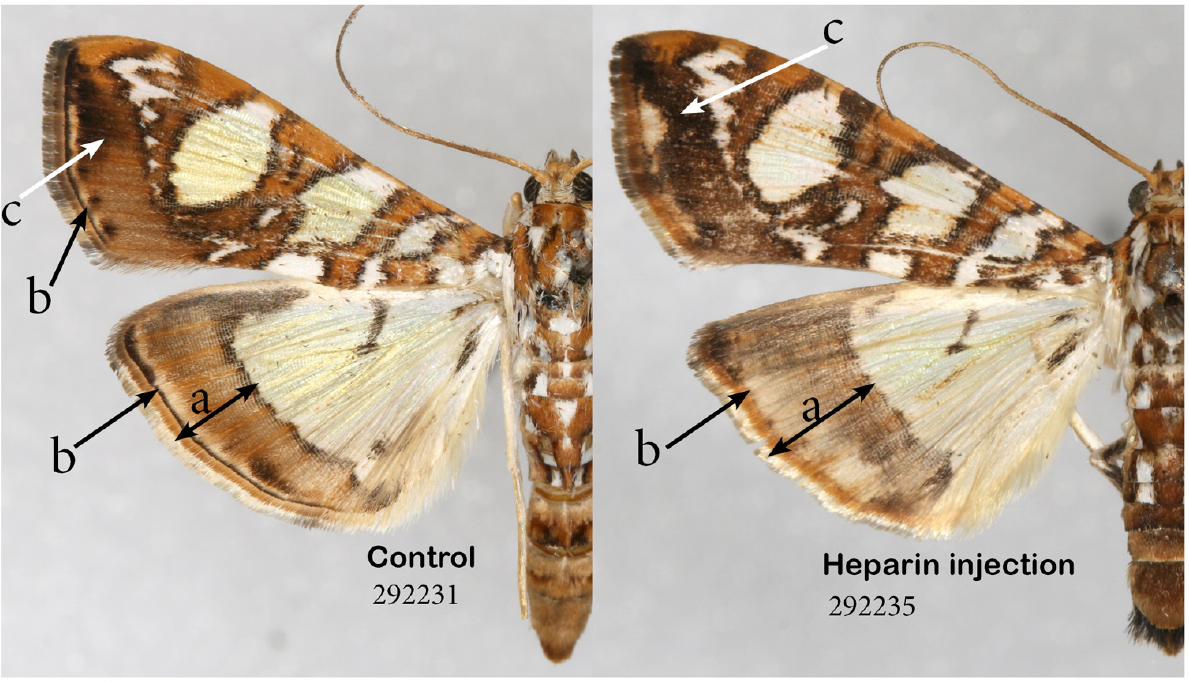
Figure 10. Normal individual of the mulberry leaftier, Glyphodes sibillalis (left) vs. heparin injected as pupa (right). Heparin causes expansion of the border area ( a ). Heparin also causes expansion of marginal band and loss of definition in submarginal band ( b ) and expansion of some of the melanic territories ( c ). See Extended Data (Sourakov, 2020) for